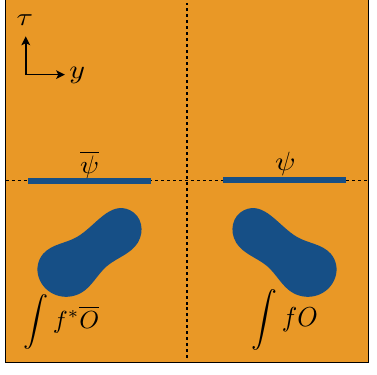
Figure 3 . Operator insertions on the (cid:28)y -plane de(cid:12)ning the smeared 4-point function